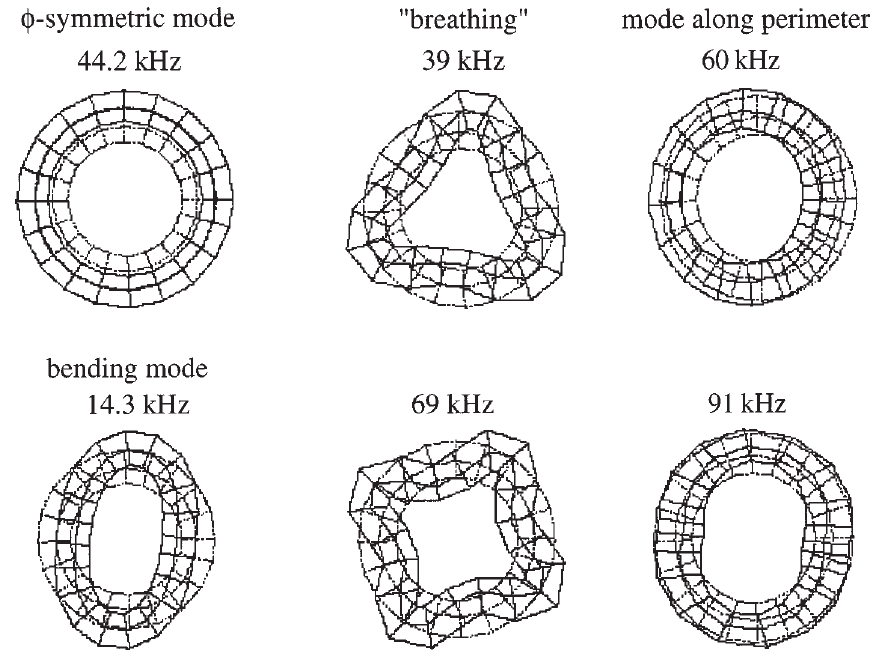
Fig. 13. Natural frequencies and modes of the radial vibrations of a pipe, calculated by a linear-elastic FE model.